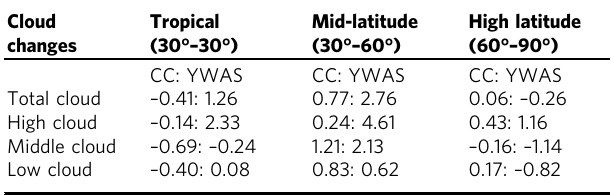
Table 1 Cloud feedbacks under climate change and in response to the Tambora eruption